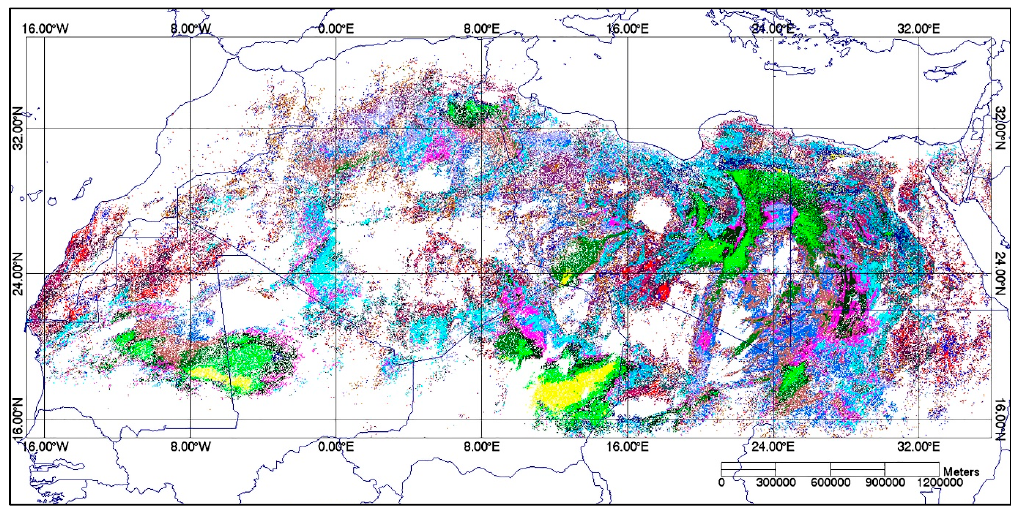
Figure 1. North Africa cluster map.